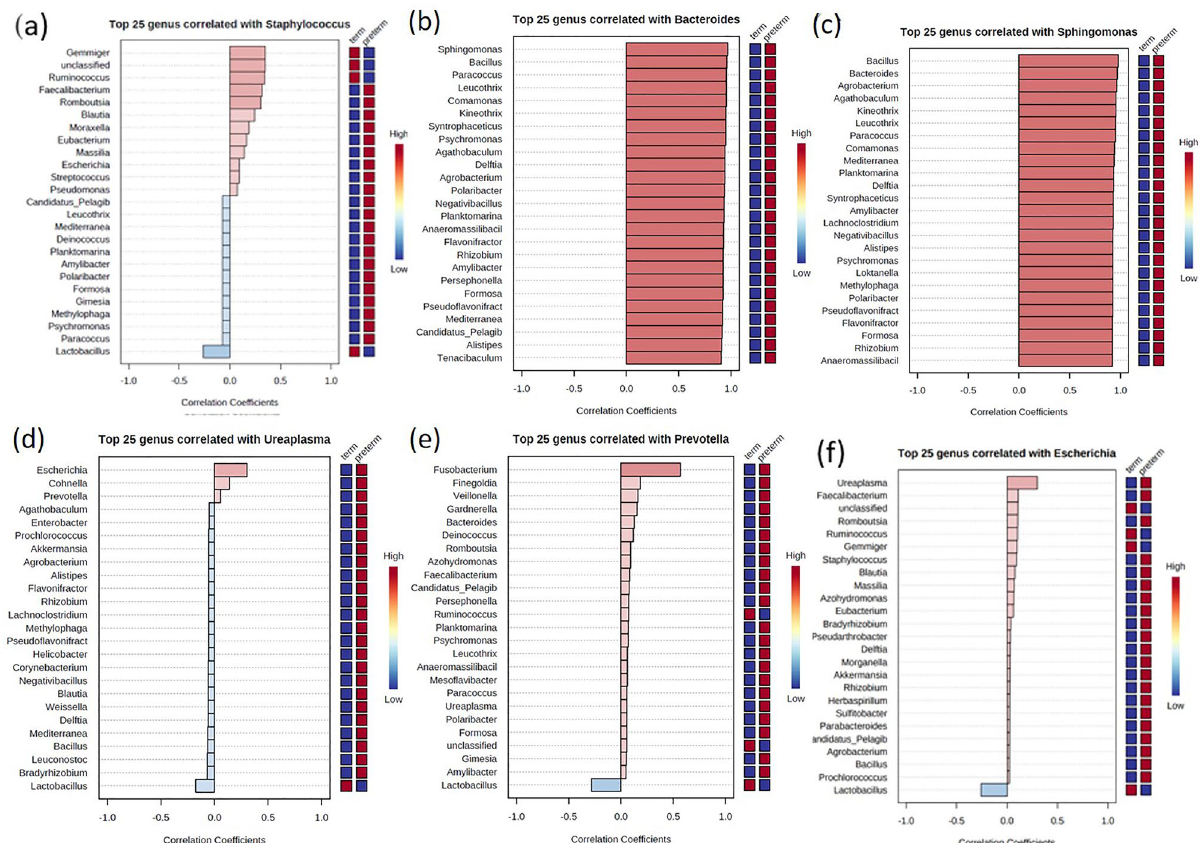
Figure 4. Pattern search using correlation coefficient analysis of the vaginal microbiome of pregnant women at the genus level. ( a ) Staphylococcus ( b ) Bacteroides ( c ) Sphingomonas ( d ) Ureaplasma ( e ) Prevotella ( f )